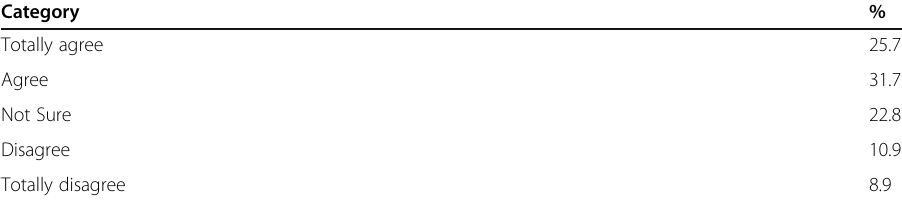
Table 7 The IELTS training courses provided by the joint college can help to improve the IELTS